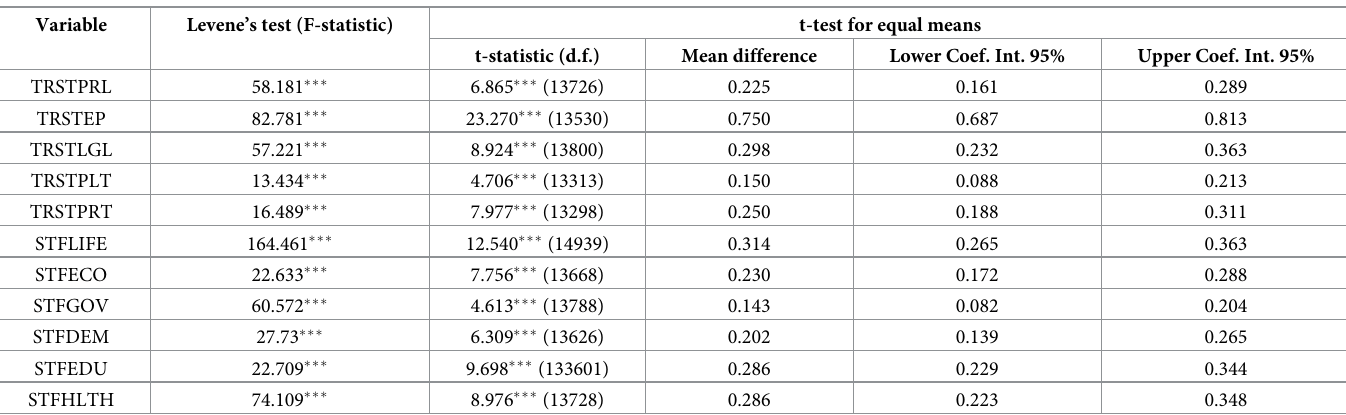
Table 2. Test for equal means.